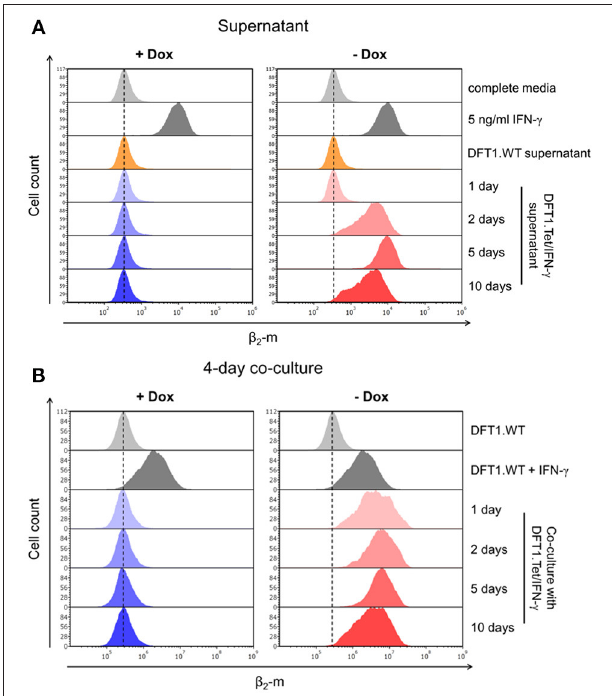
FIGURE 3 | Bystander effects of DFT1.Tet/IFN- γ . (A) Flow cytometric analysis of β 2 -m upregulation on wild type DFT1 cells (DFT1.WT) after 48h of stimulation with supernatant from DFT1.Tet/IFN- γ cultured with or without doxycycline for 1, 2, 5, and 10 days. Controls include DFT1.WT treated with complete media, 5ng/ml IFN- γ or supernatant from DFT1.WT cells. (B) β 2 -m expression on DFT1.WT cells following 4 days of co-culture of DFT1.WT and DFT1.Tet/IFN- γ . DFT1.Tet/IFN- γ were cultured either with doxycycline ( +